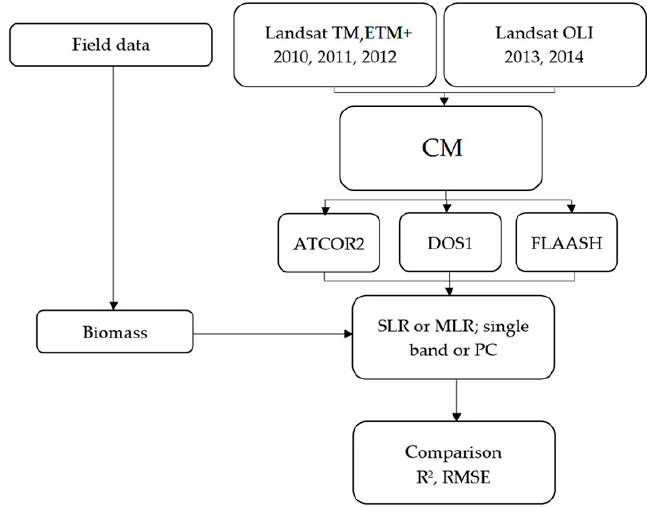
Figure 2. Flow diagram representing the procedure followed for the analysis. CM: correction method; SLR: simple linear regression; MLR: multiple linear regression; PC: principal component; RMSE: root mean square error.